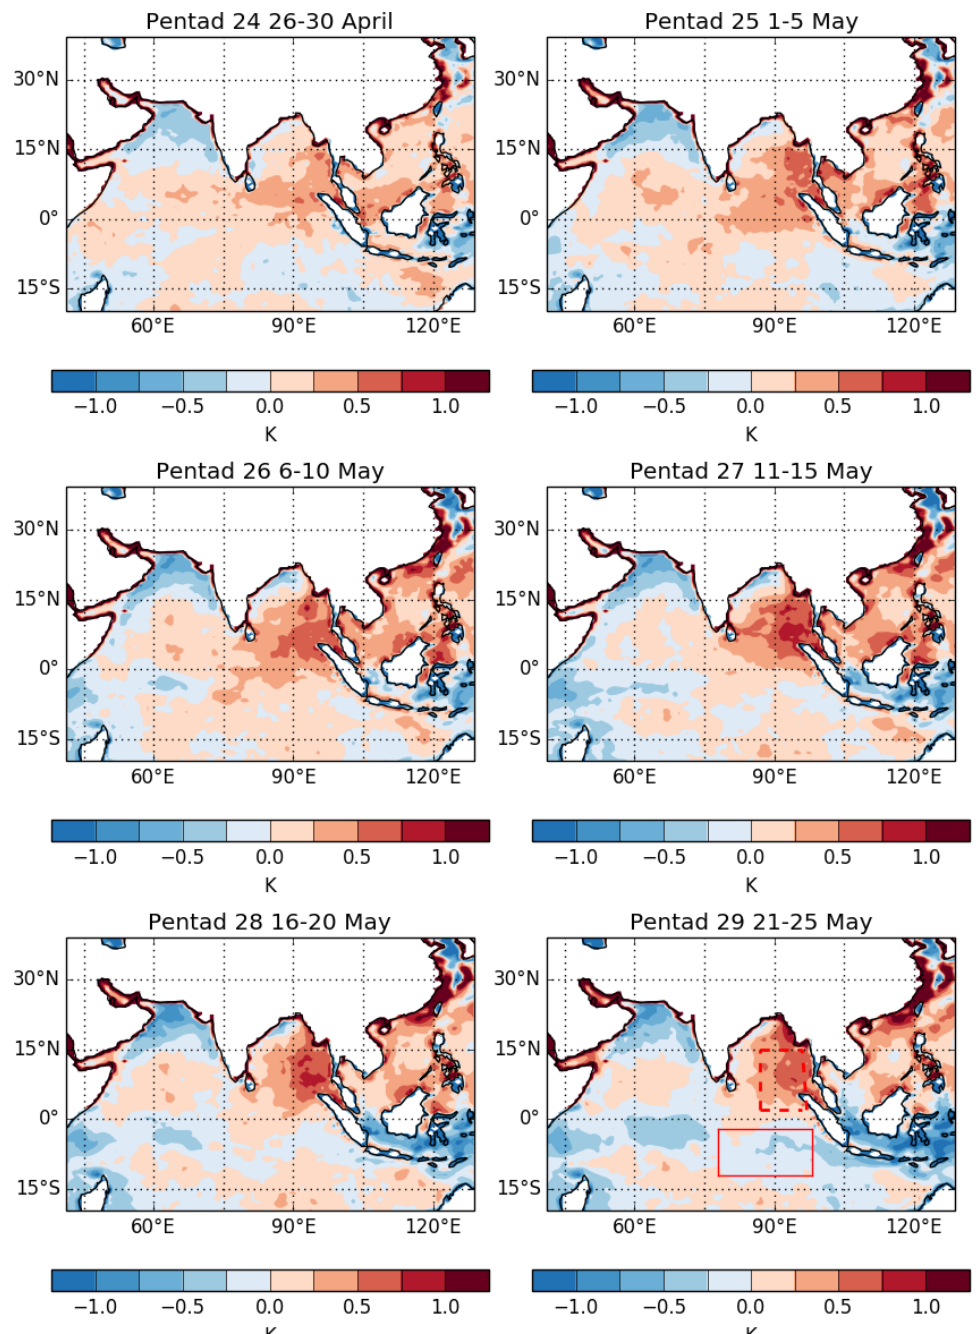
Figure 11. Development of climatological errors in SST (OISSTv2), pentad by pentad after initialisation on 25 April. The red boxes indicate the northern (dashed) and southern (solid) EEIO boxes used in Fig. 8e,